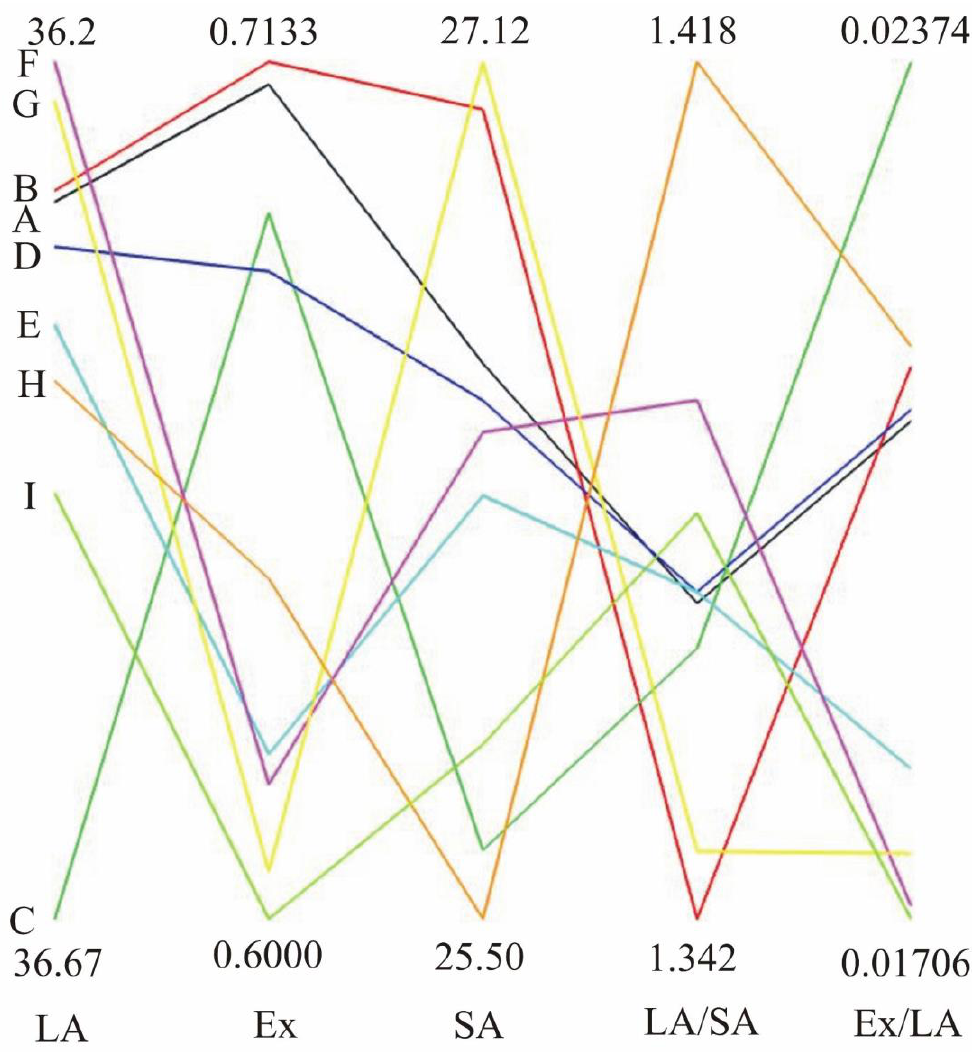
Figure 3. Parallel coordinate plots (PCPs) for nine habitats and five traits: length of the longest polar axis (LA), exine thickness (Ex), length of the shortest polar axis (SA) as well as the SA/LA and Ex/LA ratios. Habitats A–I—see Table 1.